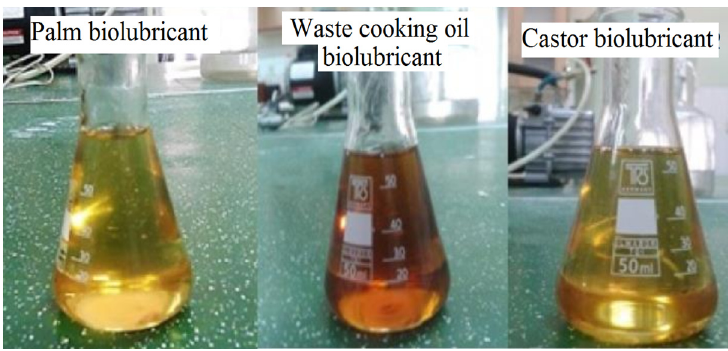
Figure 5. The biolubricants used in the engine test process.